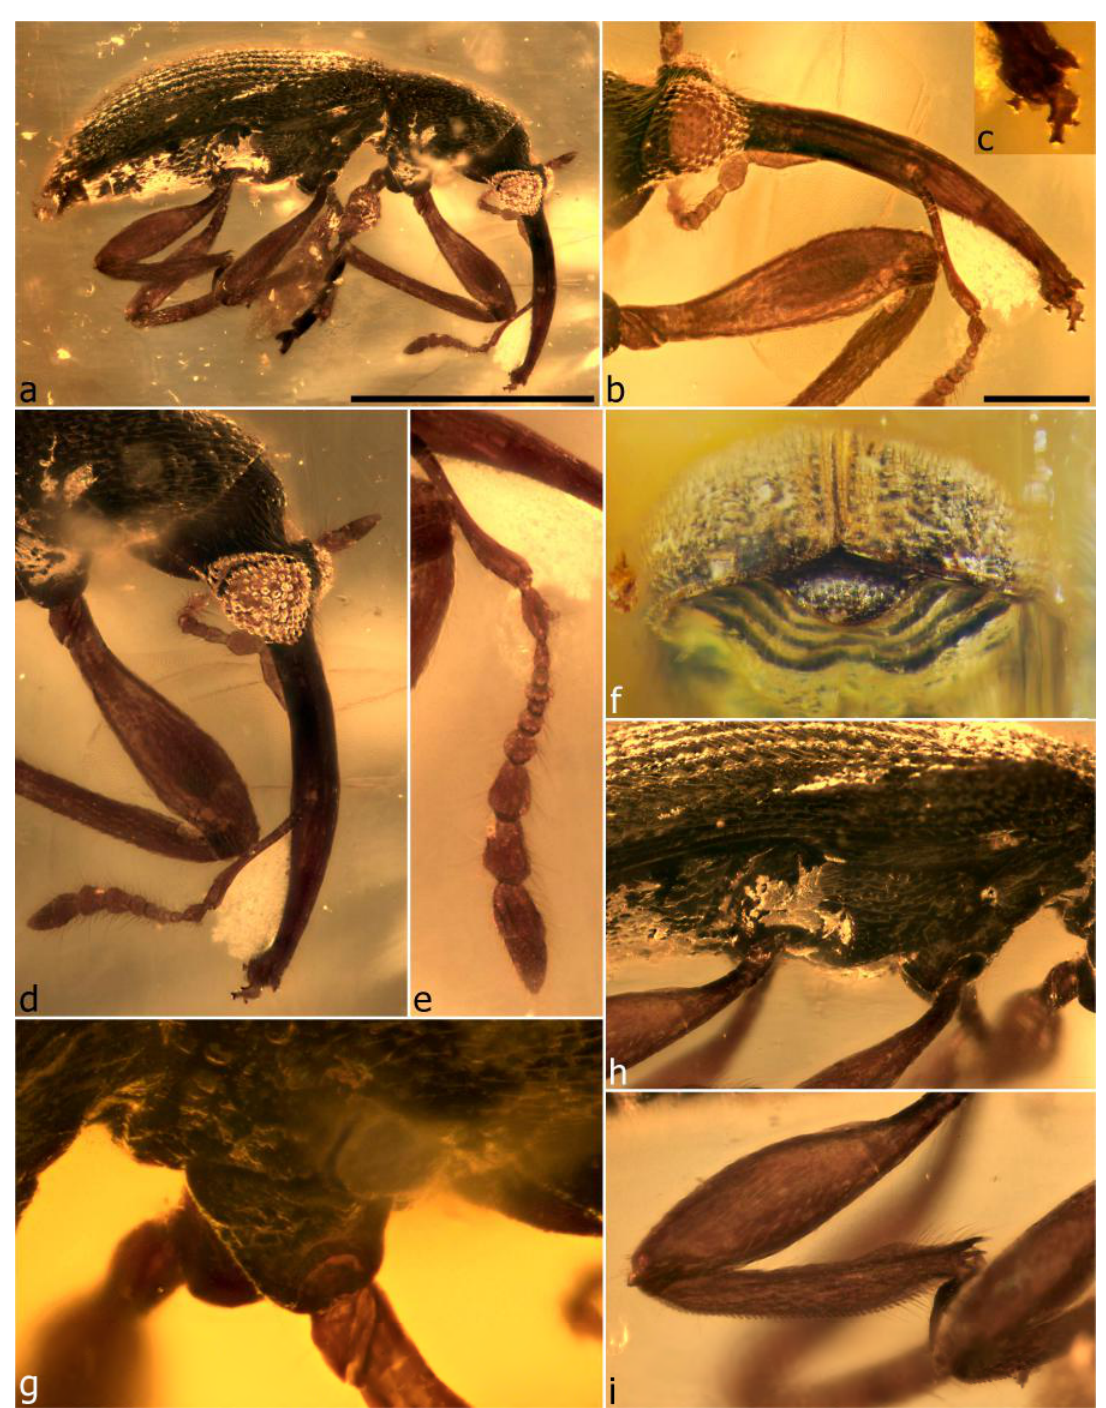
Figure 82. Bowangius cyclops sp. n., holotype. Habitus, right lateral ( a ); head and rostrum, right lateral ( b ); mandibles, right lateral ( c ); prothorax and head, right lateral ( d ); right antenna, right lateral ( e ); abdomen and elytra, caudal ( f ); detail of notosternal suture, right lateral ( g ); elytra, pterothorax and ventrite 1, right lateral ( h ); right hindleg ( i ). Scale bars: 1.0 mm (a); 0.2 mm (b).